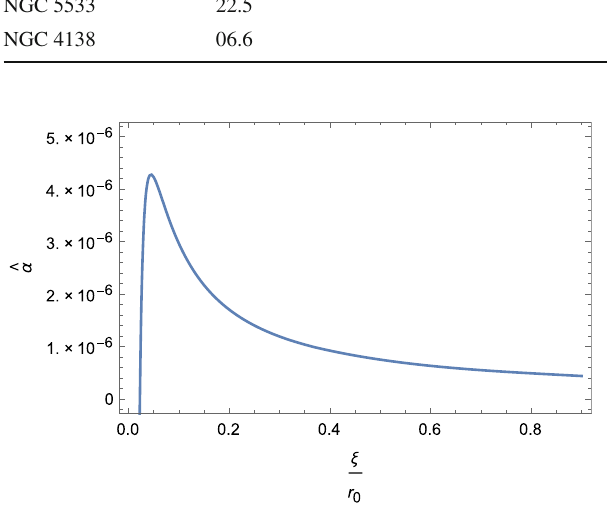
Fig. 3 f ( R ) deflection angle profile obtained for δ ≈ O ( 10 − 6 ) with the r 0 = 10 2 . 650 kpc for the galaxy NGC 5533. The deflection angle increases withmass concentrationand decreases inthe dynamical f ( R ) background geometry. The value of closest approach is approximately 22 kpc